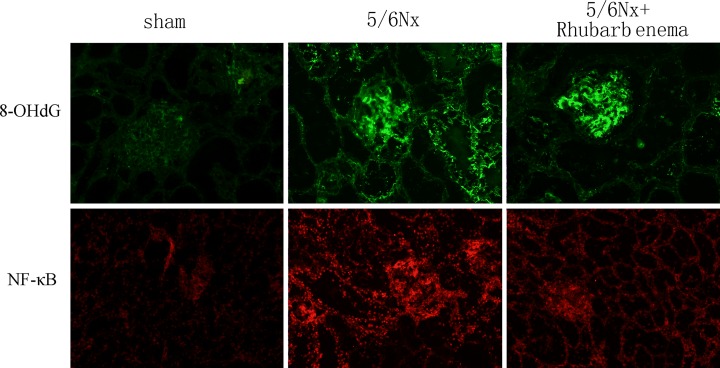
Expressions of 8-hydroxy-2'-deoxyguanosine (8-OHdG) and NF-κB in frozen sections of kidney.Localization of 8-OHdG and NF-κB in frozen sections was determined by immunofluorescence (IF) (×200) with 8-OHdG antibody (green) and NF-κB antibody (red).